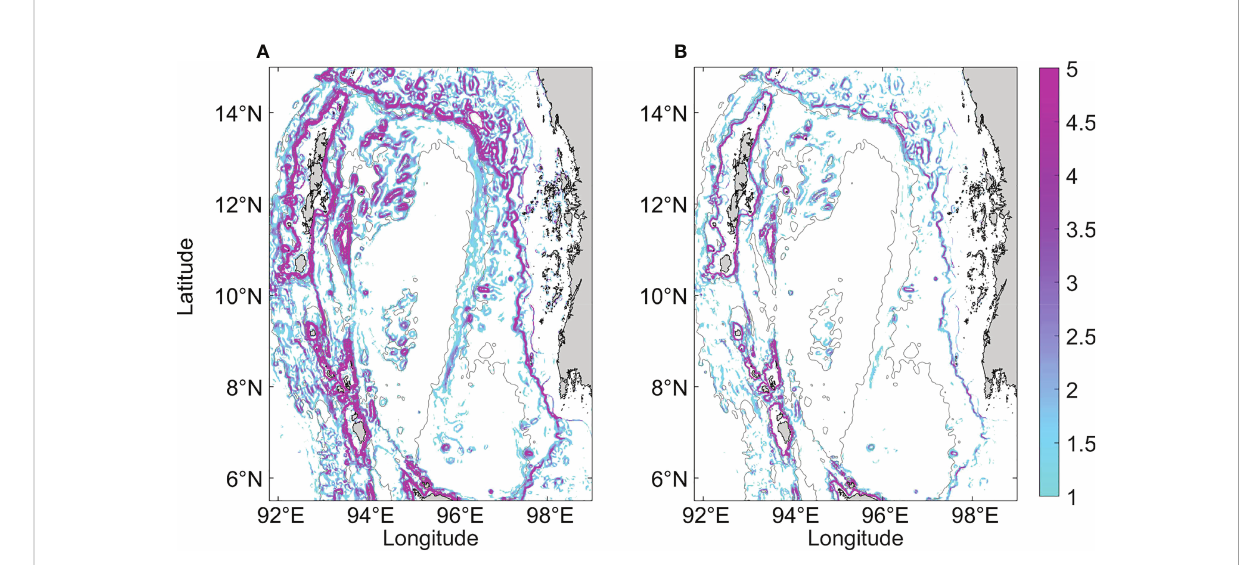
FIGURE 10 Slope criticality of (A) K1 tidal constituent and (B) M2 tidal constituent. Bathymetry contours are spaced at 500 and 2000